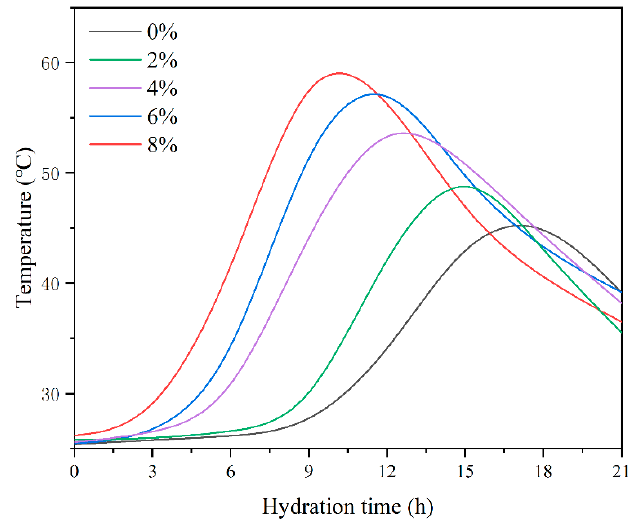
Figure 7. Hydration temperature of ultrafine calcium silicate cement slurry.